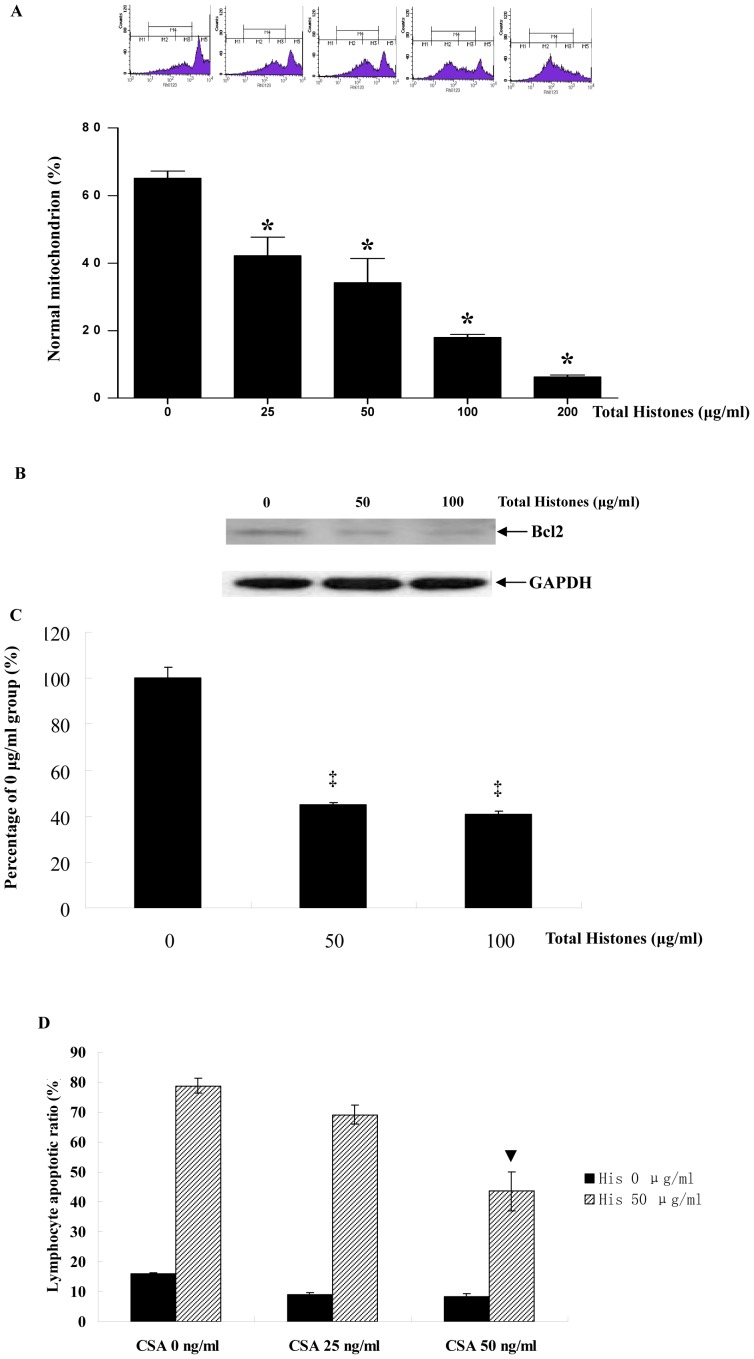
Mitochondrial injury is a key mechanism to induce histones-mediated apoptosis in lymphocytes.A. Human lymphocytes were cultured with various concentrations (0, 50, 100, 200 µg/ml) of histones. Lymphocyes were harvested 2 h after treatment and mitochondrial injury was detected by flow-cytometry. M5 represent the percentage of lymphocytes without mitochondrial injury. Values are presented as means ± SD (n = 3). *P<0.05, as compared with 0 µg/ml group. B. Western blotting results of Bcl2. Lymphocytes were harvested after histones treatment for 2 h. Equal protein aliquots of cell lysate were examined by immunoblotting with antibodies against GAPDH or Bcl2. GAPDH was used to verify equal gel loading and transblot efficiencies. C. Bar graph of relative Bcl2 intensity. Values are presented as means ± SD (n = 3). ‡P<0.05, as compared with 0 µg/ml group. D. Inhibition of mitochondrial permeability transition by CSA (25 and 50 ng/ml) can decrease the peripheral lymphocyte apoptosis. alues are presented as means ± SD (n = 3). ▾ P<0.05, as compared with CSA 0 ng/ml His 50 µg/ml group.